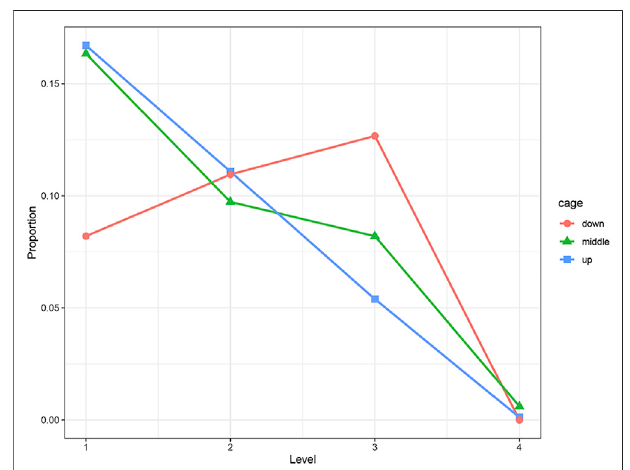
FIGURE 2 | Distribution of KB levels in different cages, where “ down ” is the fi rst fl oor, “ middle ” is the second fl oor, and “ up ” is the third fl